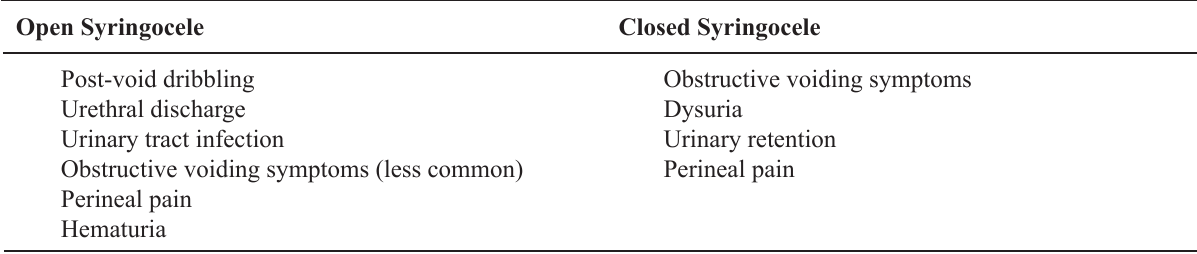
Table 1 – Common symptoms of